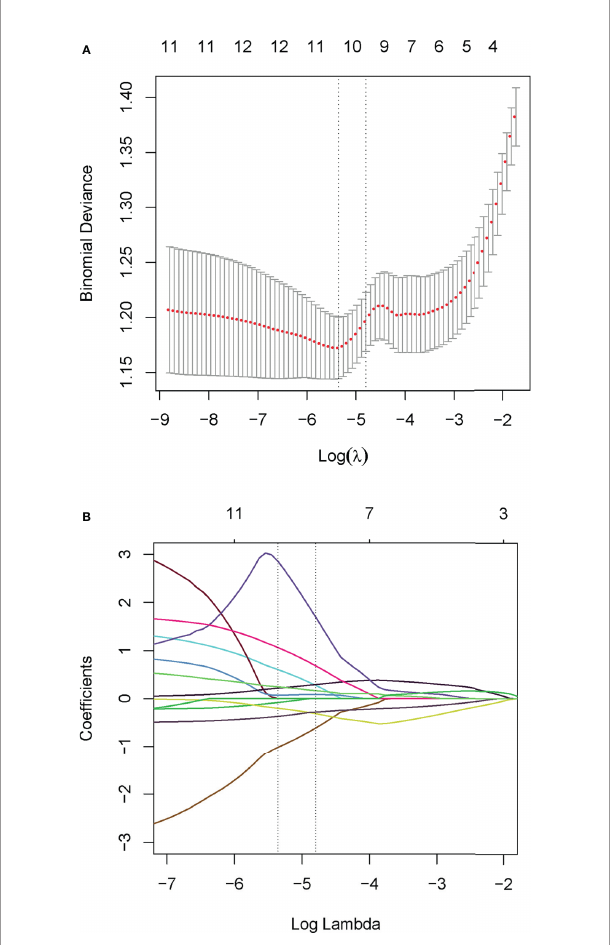
FIGURE 2 | Radiomics feature selection. (A) Tuning parameter ( l ) selection with 10-fold cross validation in the LASSO model via minimum criteria. Optimal feature selection according to AUC value. (B) LASSO coef fi cient pro fi les of the 70 radiomic features. Dotted vertical lines de fi ned the optimal values of l . The optimal l value of 0.00472 with log ( l ) of -5.36 resulting in nine nonzero coef fi cients were selected.